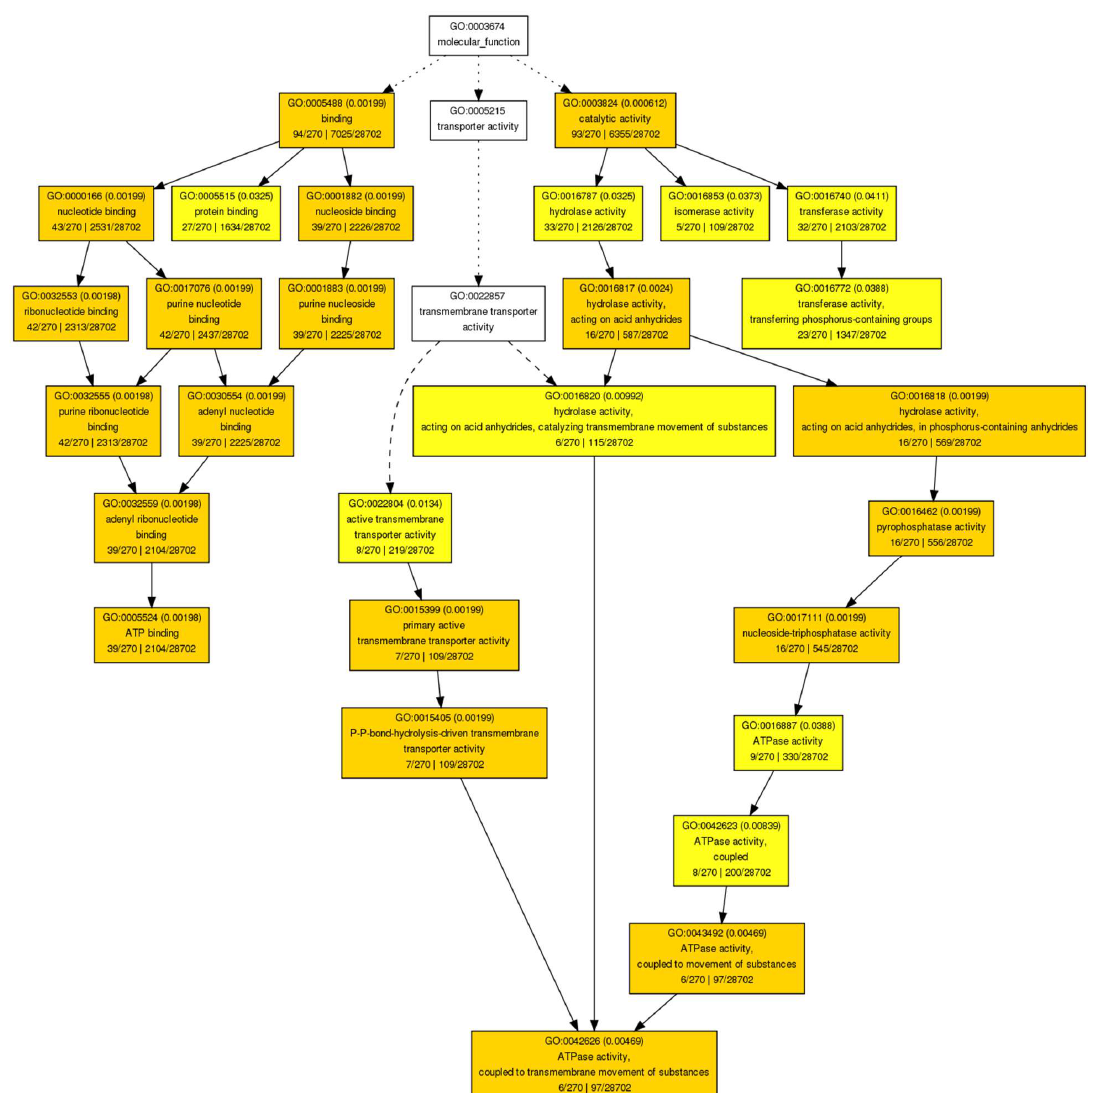
Figure 5. “Molecular function” GO terms represented in genes identified as hypomethylated in ‘Desmayo Largueta’ flower buds in both the “A” = dormant bud stage and “B” = non dormant bud stage.